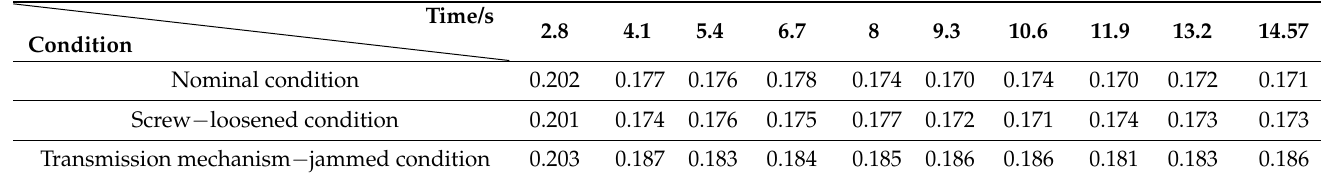
Table 1. Effective values of the stator fundamental current—time